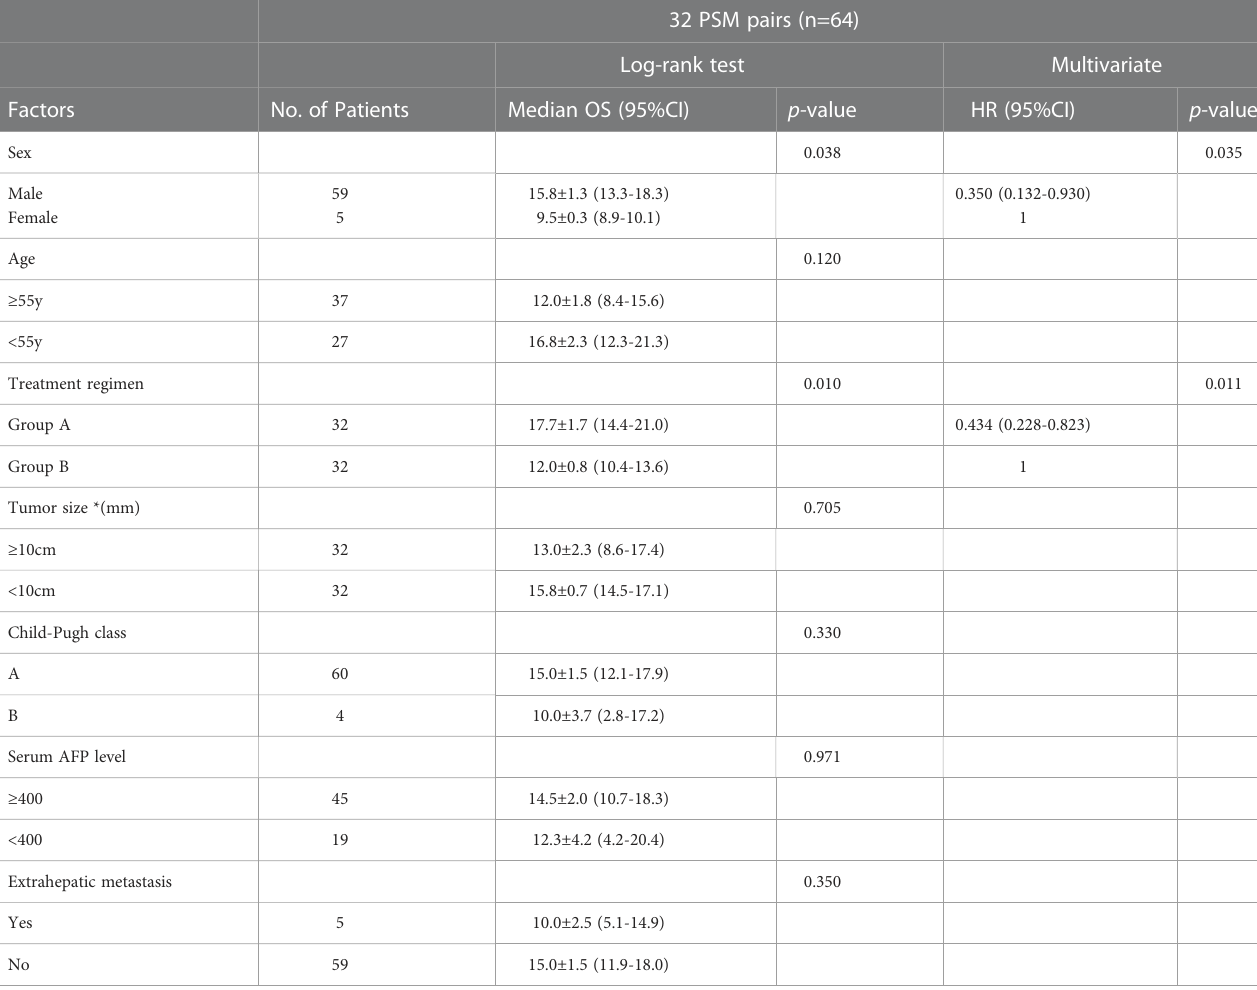
TABLE 4 Log-rank test and Cox regression analysis of factors potentially related to OS in PSM